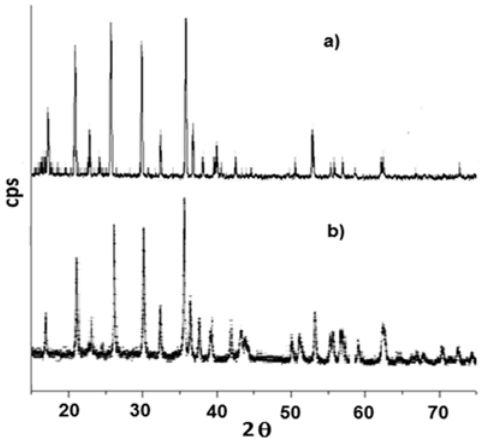
Figure 4. X ‐ ray Diffraction pattern of LiFe 0.9 Mn 0.1 PO 4 : ( a ) sample S1 : P1/ Li 2 CO 3 ; and ( b ) sample S2 : ( P2 : P3 = 0.9:0.1)/Li 2 CO 3 .